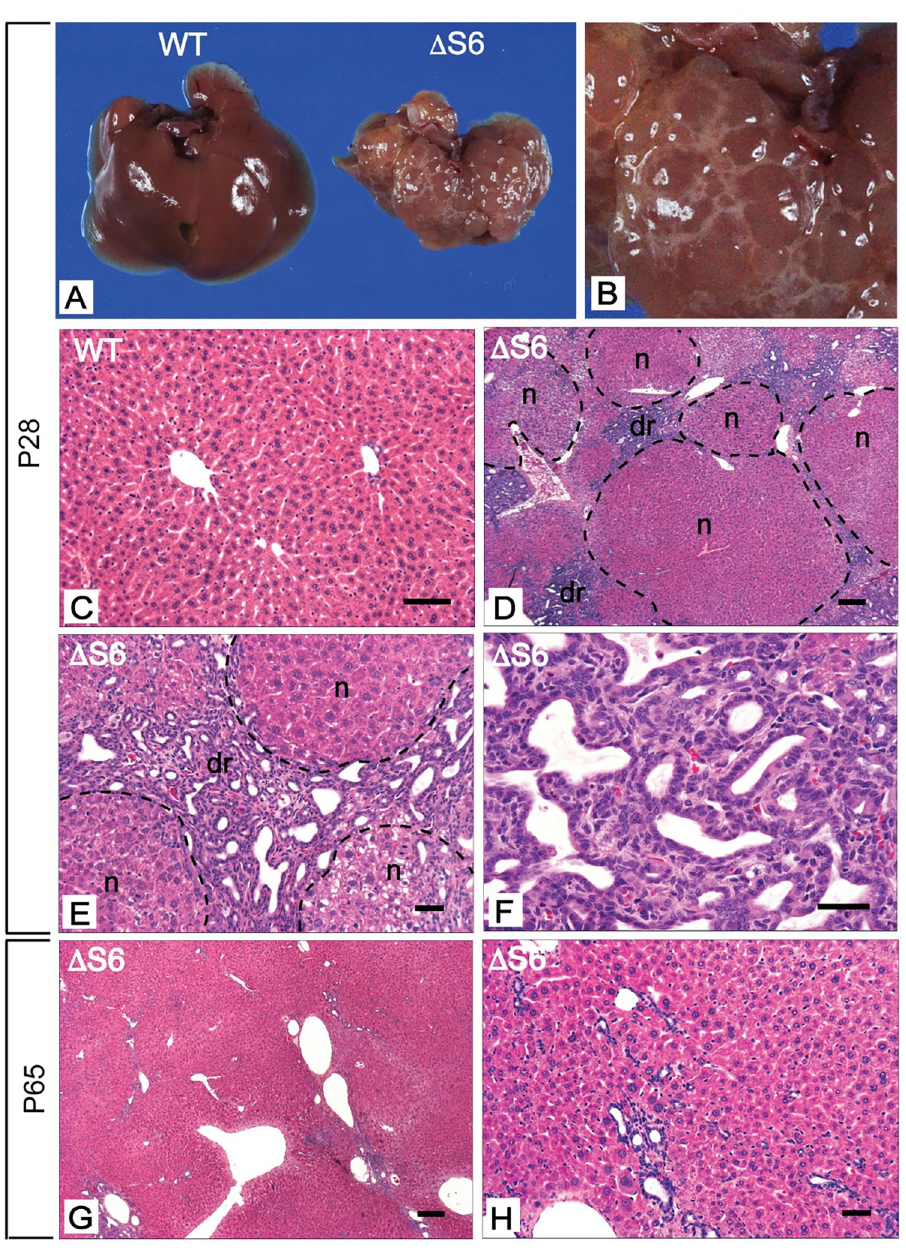
Fig 3. Perinatal deletion of hepatic Rps6 results in hypoplastic livers and triggers regeneration. (A) Gross appearance of livers from a WT and Δ S6 mouse at postnatal day 28 (P28). The Δ S6 liver is smaller than the WT liver, is discolored and has an uneven mottled appearance. (B) Close-up image of Δ S6 liver in a) highlighting “cystic-like” nodules on the surface of the liver. (C-H) Photomicrographs of H&E stained sections of liver from a WT mouse (C) and Δ S6 mice at P28 (D-F) and P65 (G and H). At P28, Δ S6 livers display an abundance of regenerative nodules (n) and a prominent ductular reaction (dr) signifying dynamic regeneration in response to severe injury. By P65, the absence of regenerative nodules indicates that the regenerative response has largely dissipated. However, hepatocyte morphology is heterogeneous and remnants of the dr persist as seen by the presence of irregular luminal structures in the vicinity of portal veins (g, h). (Original magnifications, C (x 112); D, G (x 32); E, H (x 125) and F (x 250)). Scale bars correspond to 50 μ for C, E, F and H and 200 μ for D and G.